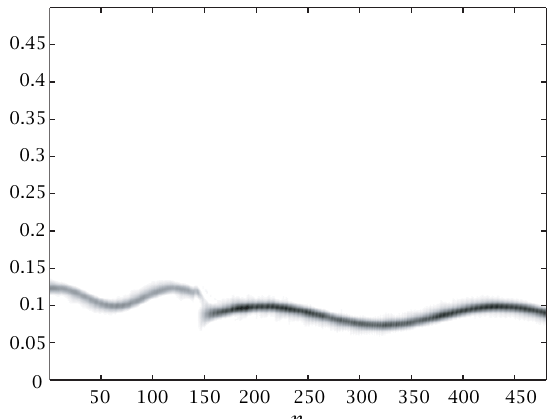
Figure 4: Estimated instantaneous spectrum of the density f(t) when a sequence t i of events is given. The number of events is four times the number of samples of the numerical version of f(t) .